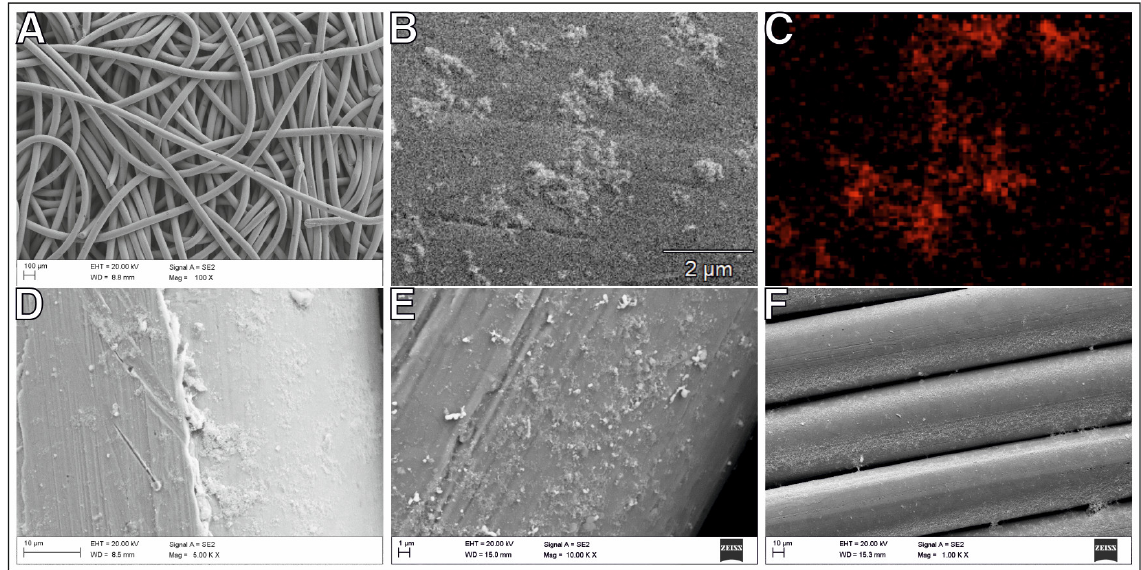
Figure 2. Scanning electron microscopy (SEM) images for nanometal/Ni-wool catalysts;( A ) Ni-wool support fibers with Ru nanoparticles, ( B ) Ru nanoparticles on the support surface, ( C ) Ru nanoparticles (red spots) after EDS mapping, ( D ) Re nanoparticles on the fiber surface, ( E ) Pd nanoparticles on the fiber edge surface, ( F ) support fibers covered with Au nanoparticles.